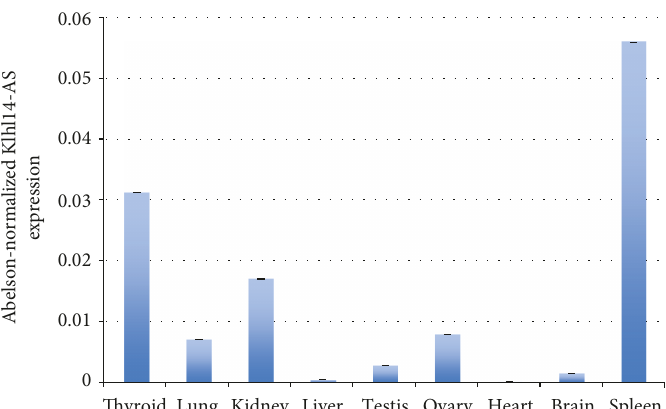
Figure 3: Klhl14-AS expression in adult mouse organs. Quantitative real-time RT-PCR was performed by amplifying a region shared by Klhl14-AS isoforms on total RNA from adult mouse organs. The data are reported as normalized by Abelson expression. Three replicates for each experimental point were performed. Error bars represent standard deviation of normalized ct values. Data are representative of three independent